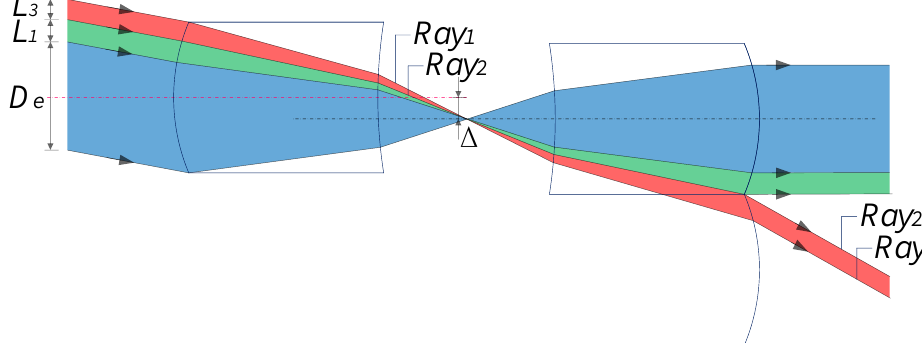
Figure 4. Schematic of the MLA system at the maximum swing angle.